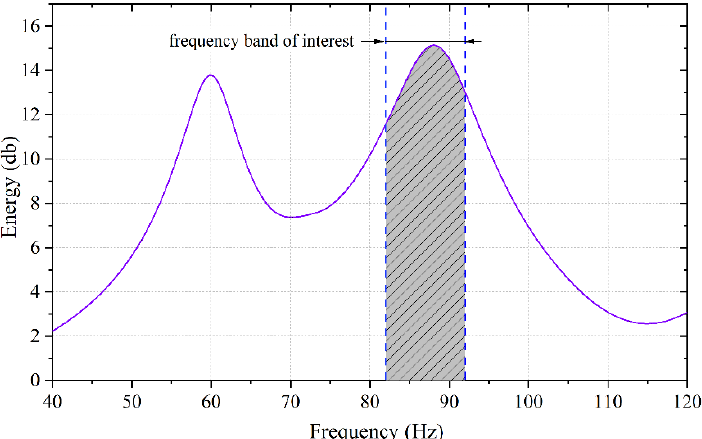
Figure 5. Energy – frequency response of initial configuration calculated by the FOM of the S-shaped curved stiffened shell.